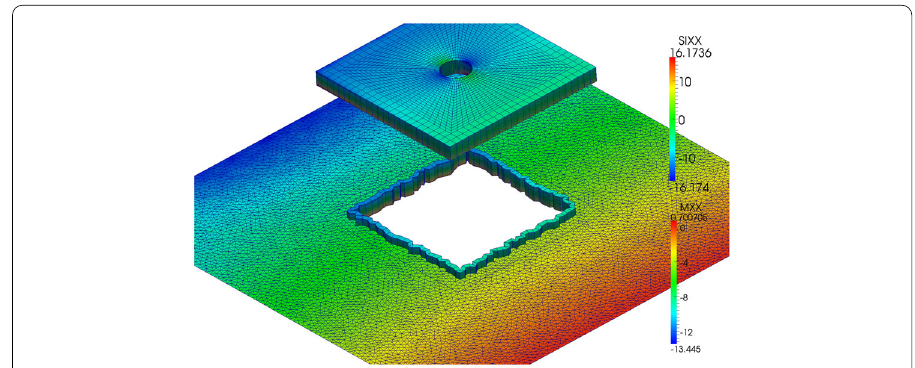
Fig. 10 Exploded view of the plate/3D coupling with non-matching meshes. The interior of the Auxiliary model is not drawn in order to better see the intermediate mesh used for the stress